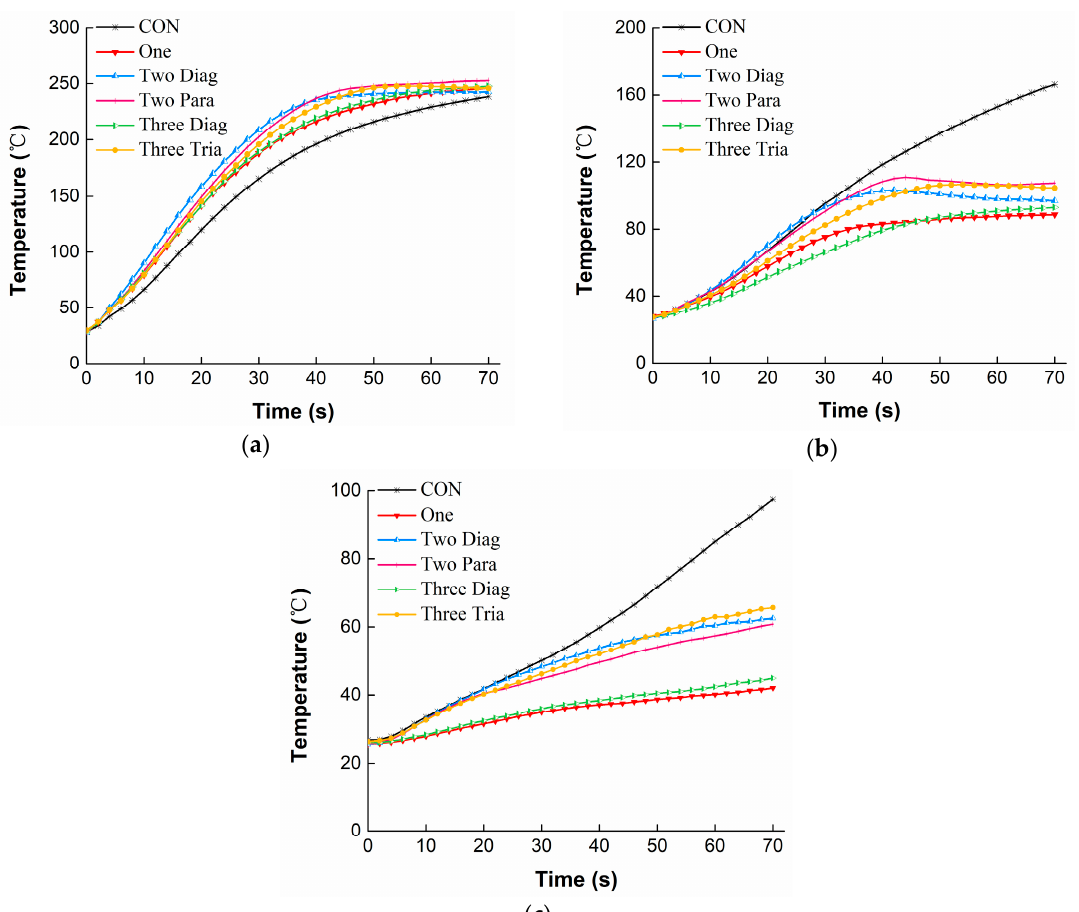
Figure 4. Temperatures for different arrangements of No-cut SMA spring under RHE: ( a ) The external surface of the moisture barrier; ( b ) The external surface of the thermal liner; ( c ) The internal surface of the thermal liner.